Question: What visual encoding does this figure use to show its data?
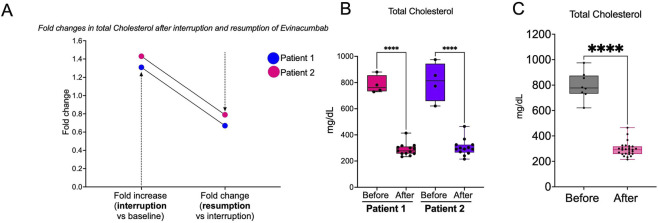
Answer: box